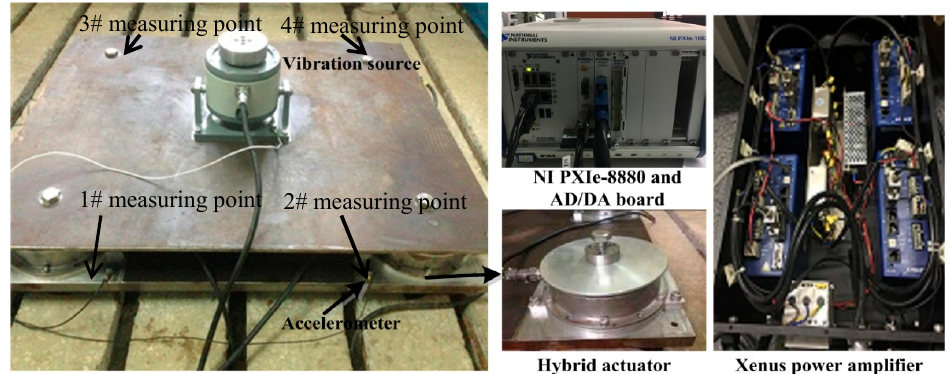
Figure 14. Test rack and some equipment.